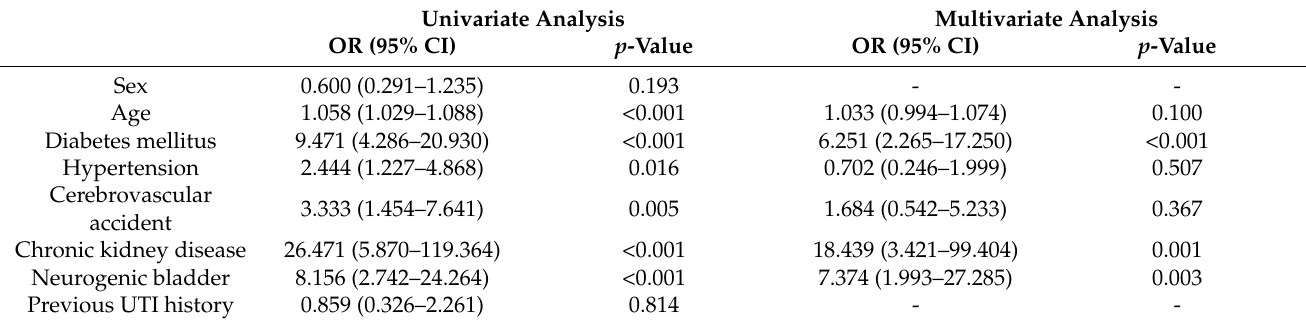
Table 2. Univariate and multivariate analysis of the risk factors for emphysematous cystitis. Univariate Analysis Multivariate Analysis p -Value p